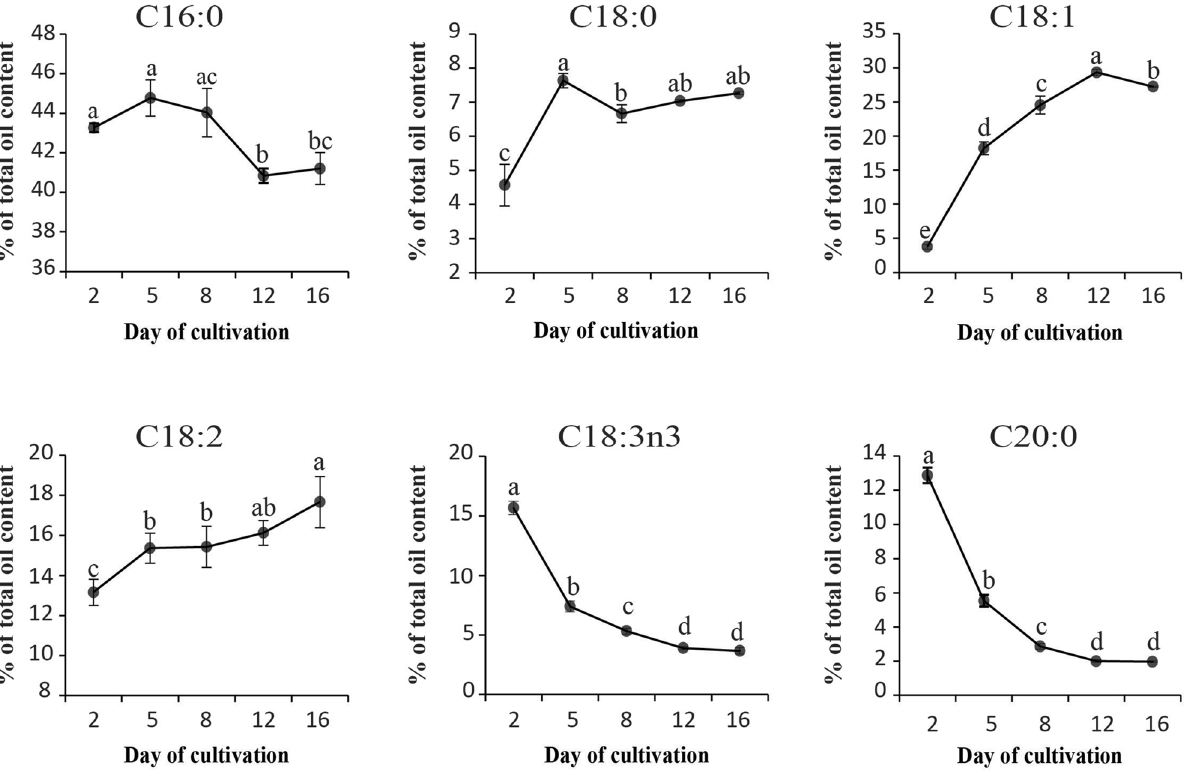
Figure 5. The major fatty acid compositions of C. vulgaris UMT-M1 at different growth phases under 15 ppt culture condition. All values represent means ± SD of three biological replicates. Different series of letters are significantly different according to Fisher’s LSD test (SPSS software) ( p <